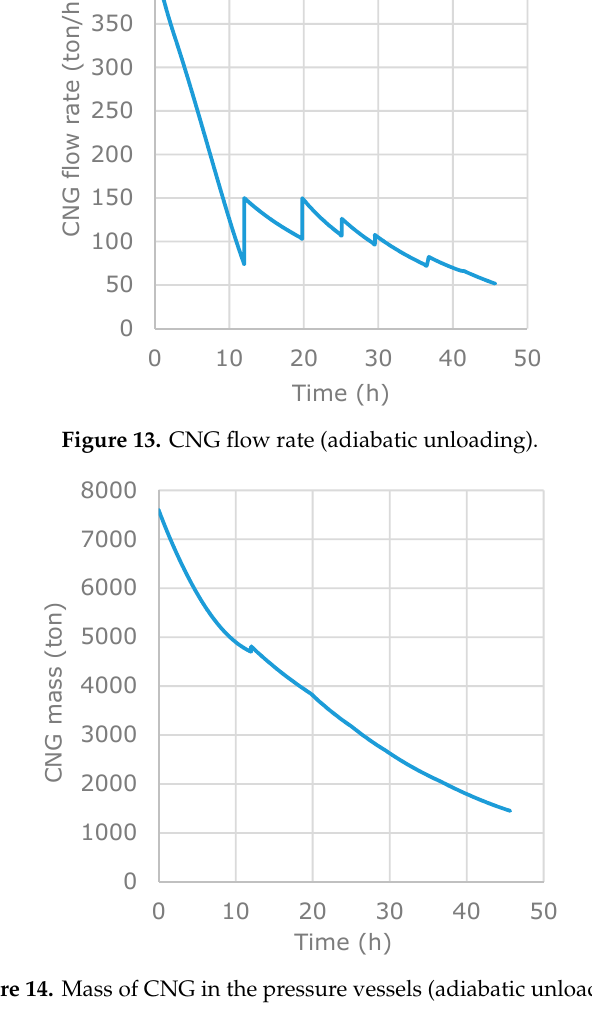
Figure 15. Compression ratio (adiabatic unloading).